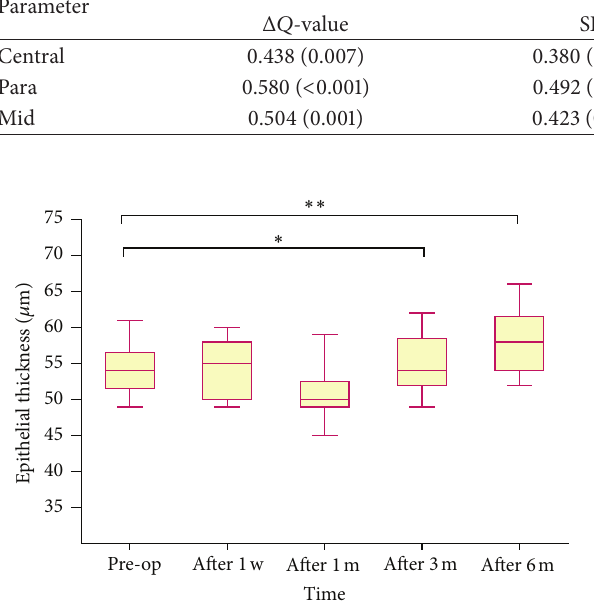
Figure 1: Change in central corneal epithelial thickness over time after T-PRK. The epithelium was significantly thicker at 3 and 6 months after surgery compared with preoperative measurements. ∗∗ 𝑃 < 0.001 , ∗ 𝑃 < 0.05